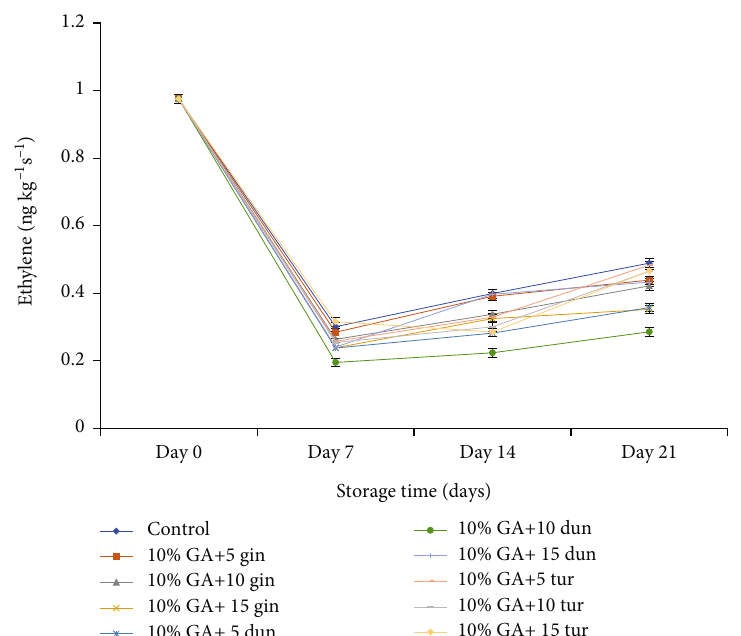
Figure 12: E ff ect of 10% GA incorporated with plant extracts at di ff erent concentrations on ethylene production during cold storage for 21 days. Table 1: Sensory evaluation of dragon fruits treated with plant extracts at di ff erent concentrations incorporated with 10% GA.